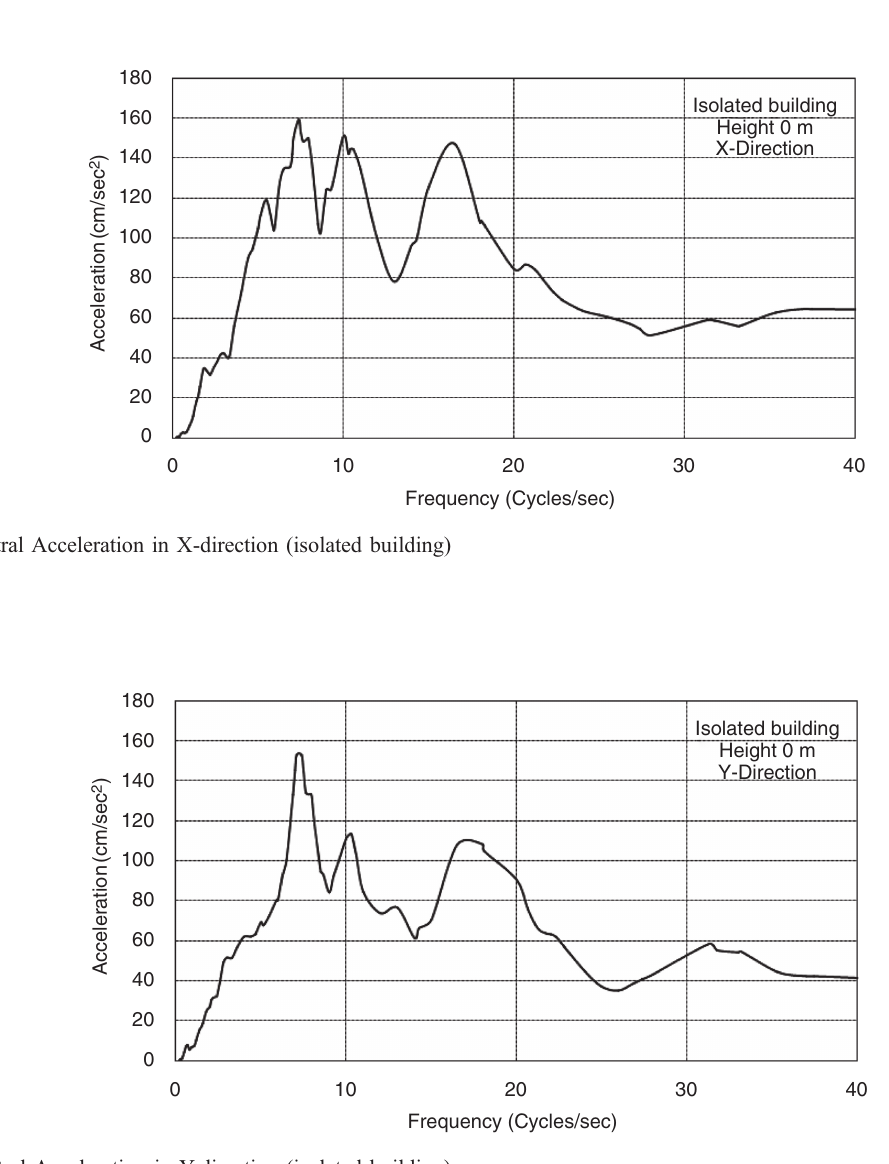
Fig. 15. Spectral Acceleration in Y-direction (isolated